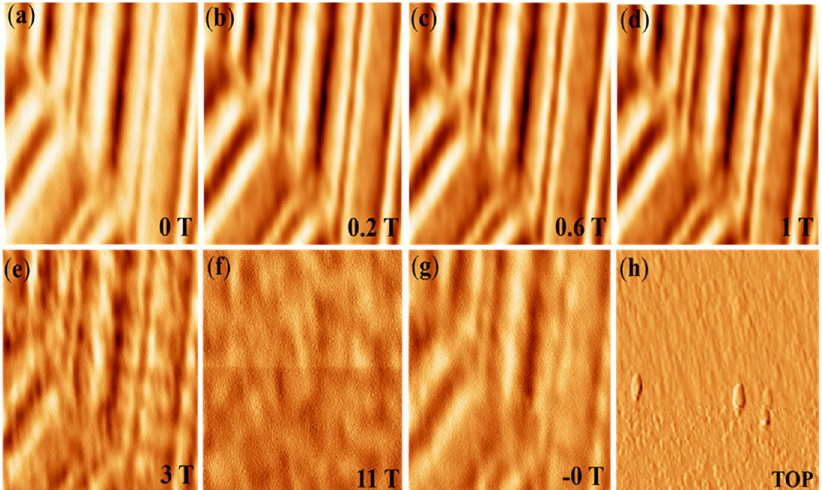
Figure 5. ( a – g ): Evaluation domain of commercial videotape tracks at 5 K with changing magnetic field from 0 T to 11 T; the tip ‐ sample distance ( a ) is 100 nm and ( f ) is 500 nm, respectively; the image size is 12 μ m × 12 μ m, and ( h ) shows the topography image of the same scan area.